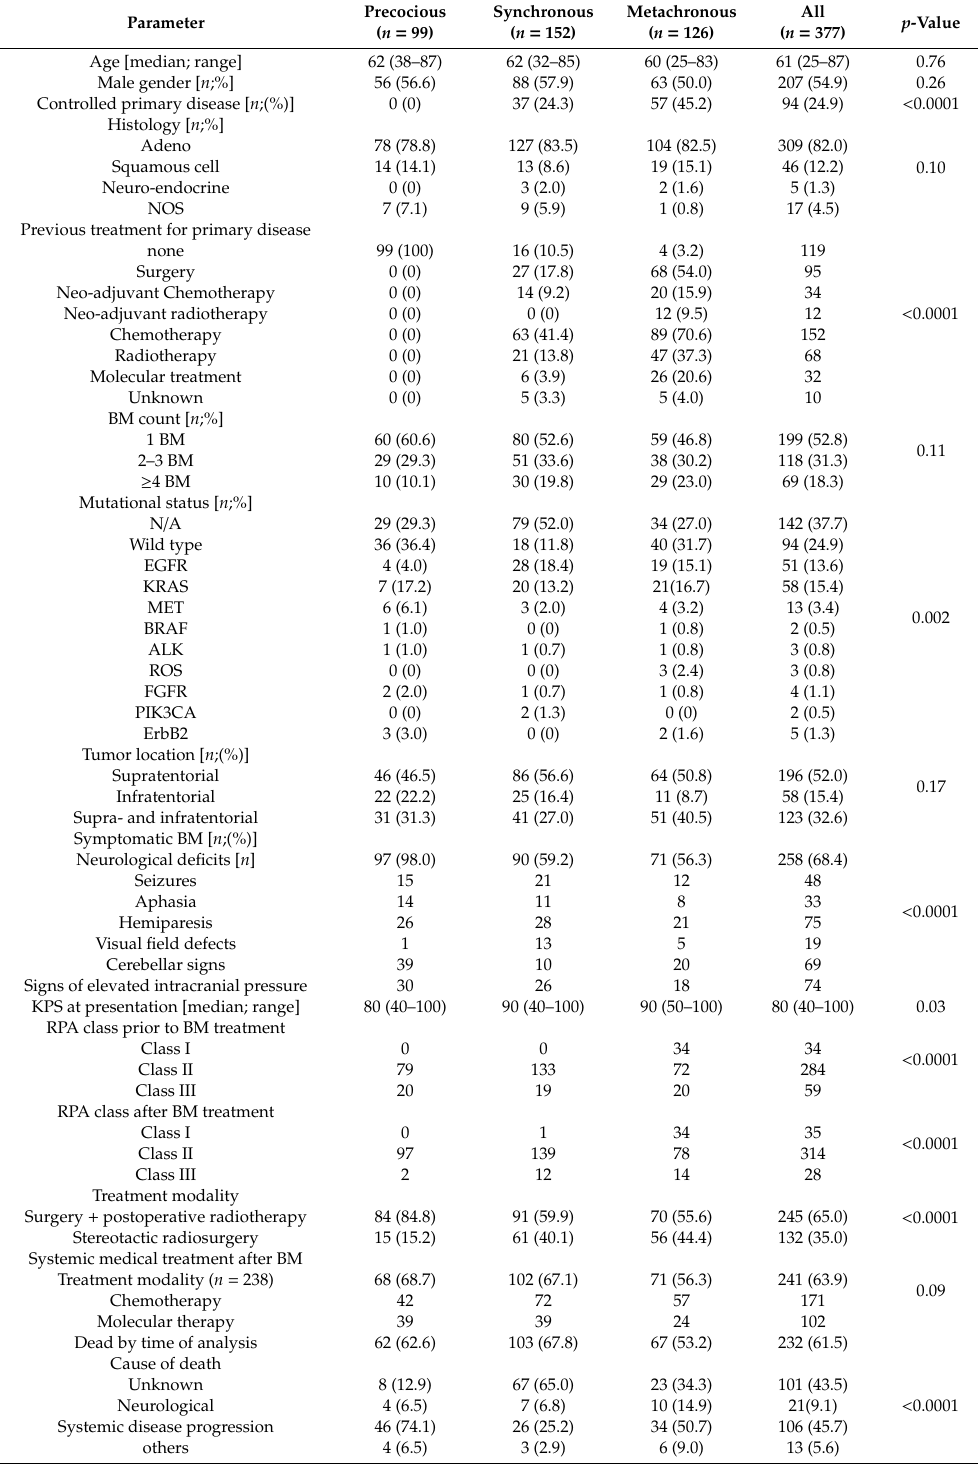
Abbreviations used in Table 1: ALK (anaplastic lymphoma kinase), BM (Brain metastasis / es), BRAF (v-raf murine sarcoma viral oncogene homolog B1), EGFR (epidermal growth factor recetor), ErbB2 (Erb-B2